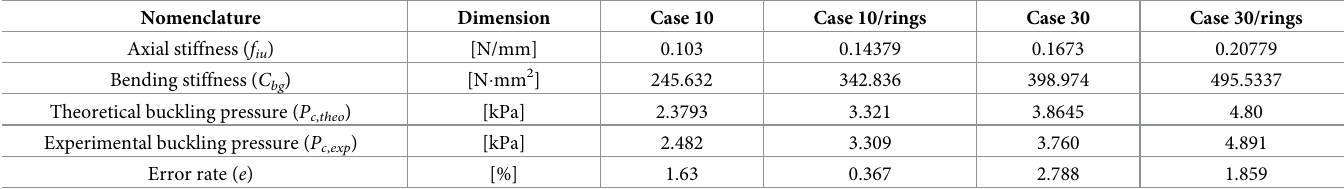
Table 3. Mechanical parameters and results of the buckling